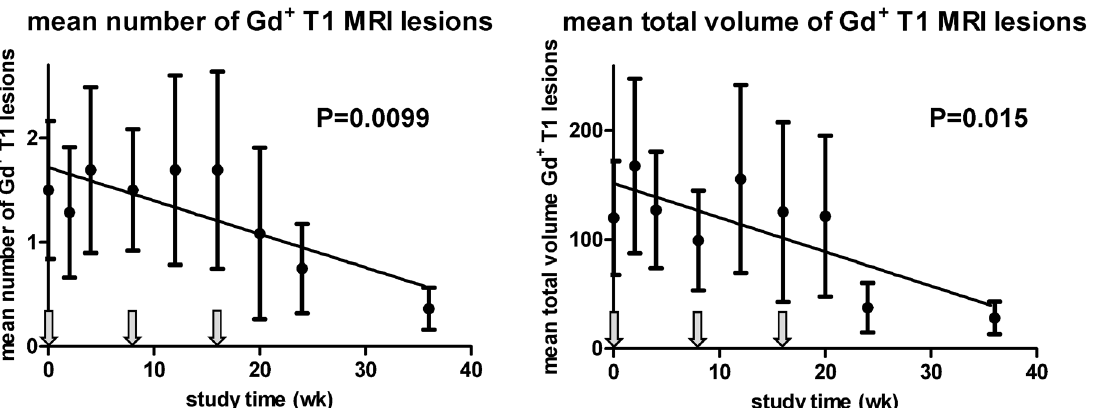
Fig 5. Decline in MRI lesions RR-MS patients treated with the two lower doses of HspB5. RR-MS patients received three bimonthly intravenous administrations of either 7.5 or 12.5 mg HspB5, and mean numbers as well as total volumes of Gd + T1 lesions for the combined groups were evaluated by MRI over the course of 36 weeks. Data show mean values ± standard deviation, as calculated for the full analysis set of patients, including readings for 11 to 14 subjects at different time points. Linear regression analysis was used to evaluate the trends of change over 36 weeks; p values reflect the probability that the deviation of such trends from a horizontal line is a chance event. Arrows indicate times of administration of HspB5.